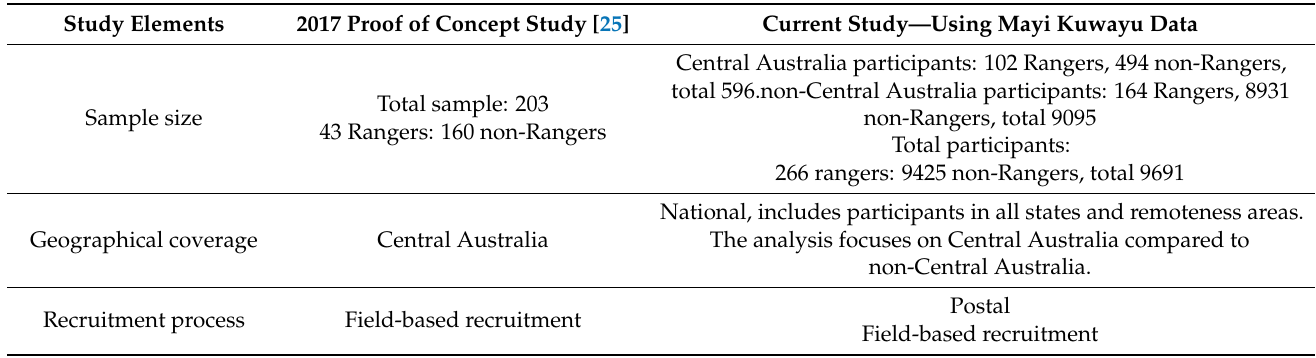
Table 1. Comparison between 2017 proof-of-concept study and current study using Mayi Kuwayu baseline data. Study